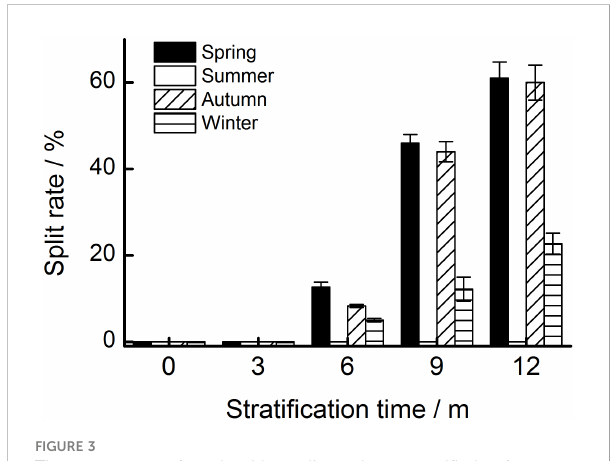
FIGURE 3 The percentage of seeds with a split seed coat strati fi ed at four seasonal temperature regimes. The vertical bars represent standard errors of the mean (n =